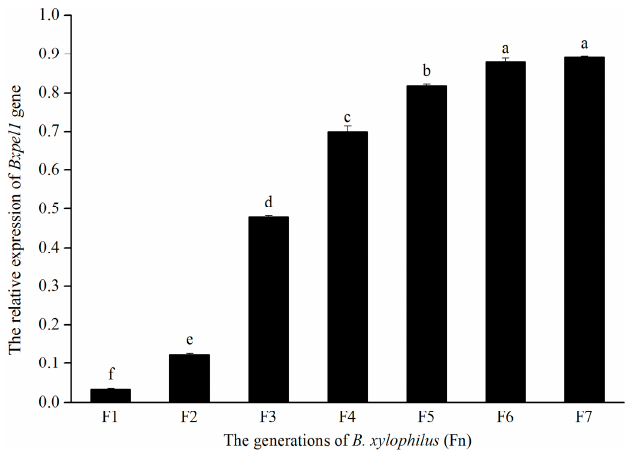
Figure 6. Expression of the Bxpel1 gene in B. xylophilus. Vertical bars indicate standard deviation of the means ( n = 3), and different letters indicate significant differences at a level of p < 0.05 based on Tukey’s test. F3: third generation; F4: fourth generation; F5: fifth generation; F6: sixth generation;